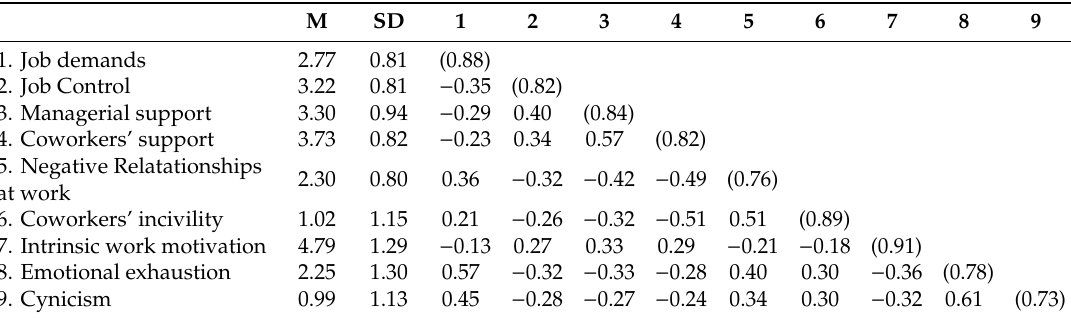
Table 1. Means (M), Standard Deviations (SD), and correlations between study variables.